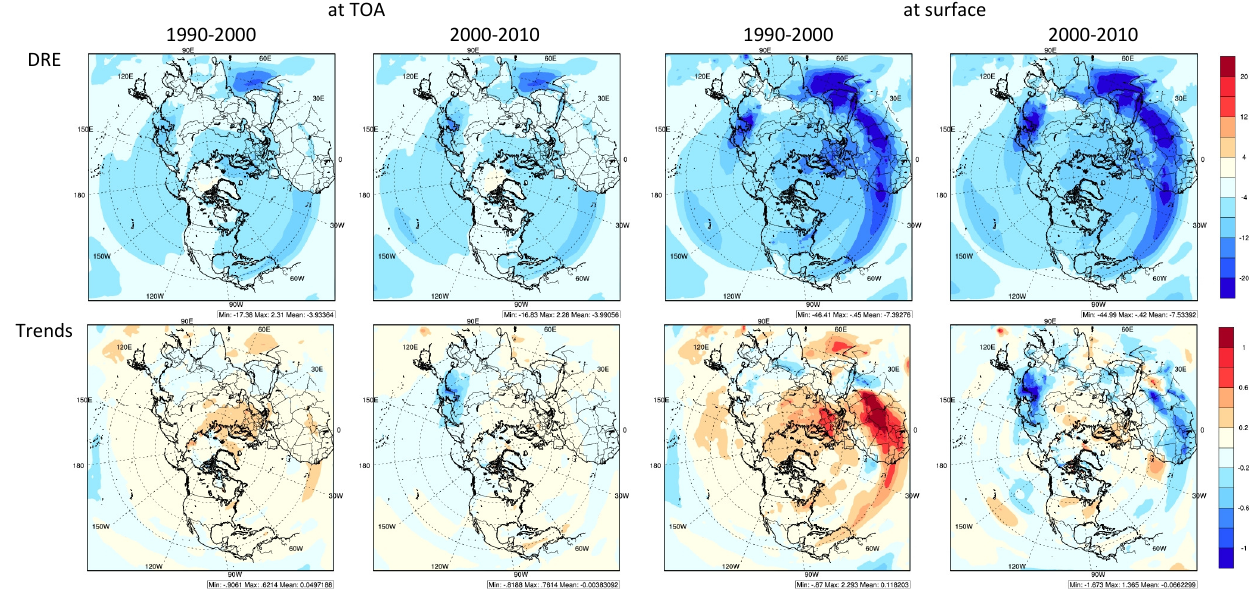
Figure 9. Spatial distributions of simulated DRE and its trends (Wm − 2